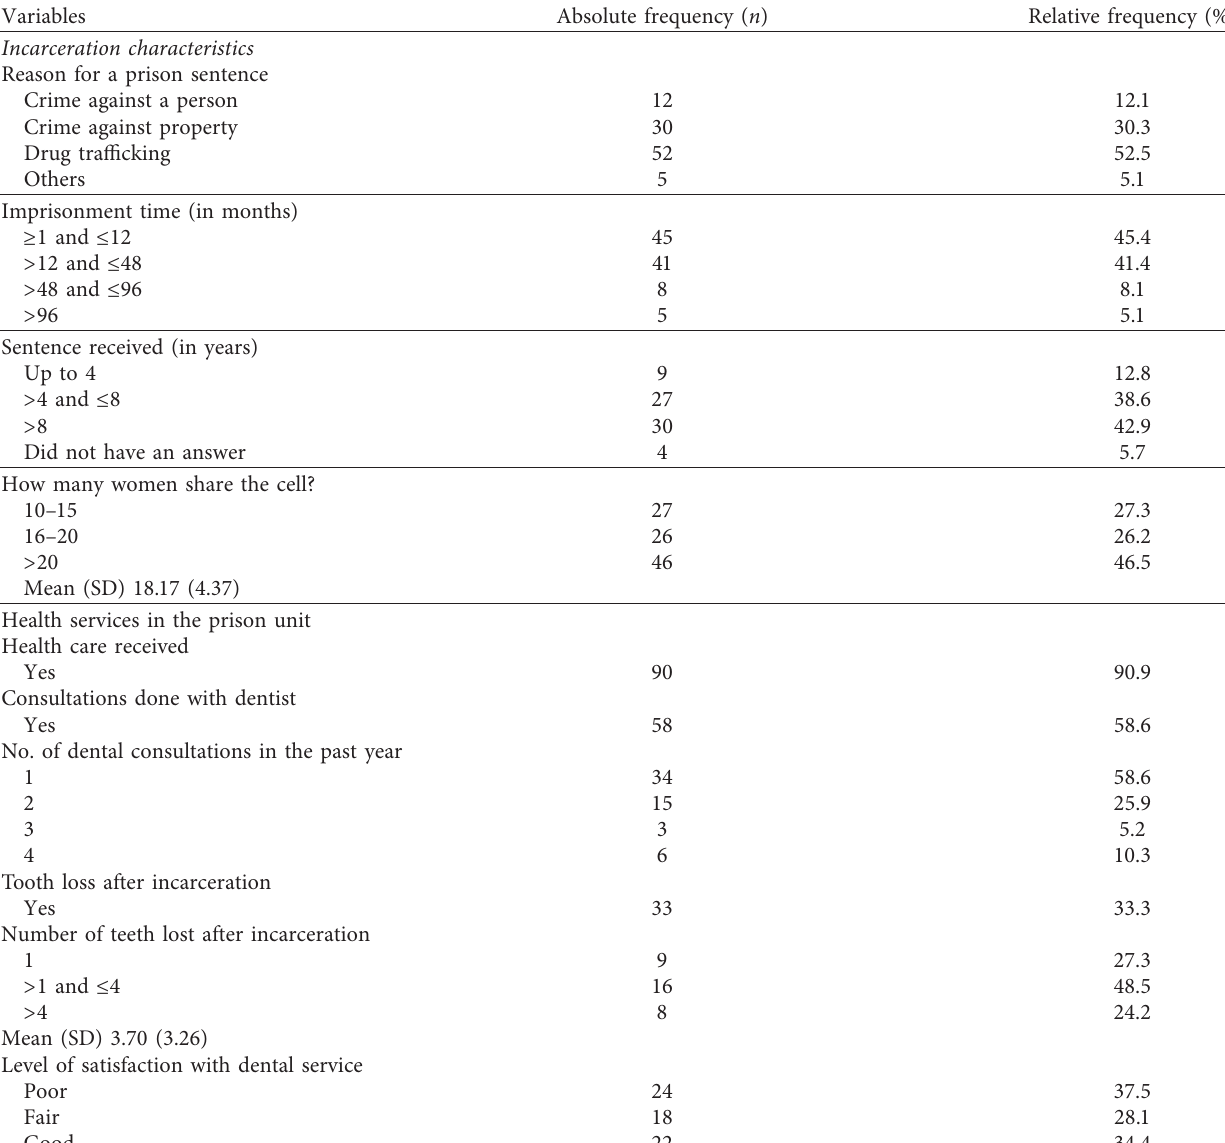
Table 2: Incarceration characteristics and use of health services in the prison unit, women inmates in Juiz de Fora, 2020.